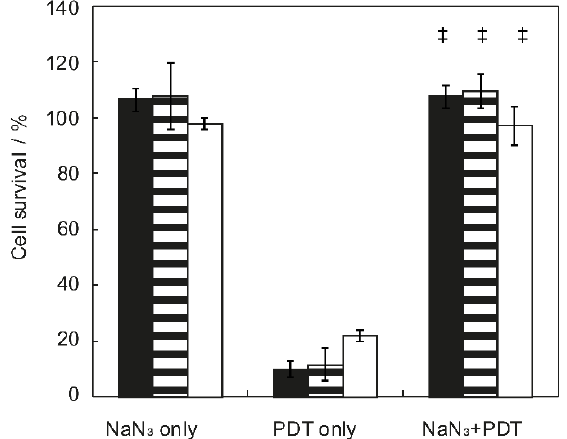
Figure 2. Cell survival of OSC-19-luc2-cGFP (black bar), scc-U2 (dashed bar), and scc-U8 (white bar) cells treated with either NaN 3 only, cetuximab-IRDye700DX mediated photodynamic therapy (PDT) or the combination using a 24 h DLI and illuminated with 20 mW·cm − 2 to a fluence of 15 J·cm − 2 for OSC-19-luc2-cGFP and scc-U2 and 7 J · cm − 2 for scc-U8. ‡ statistically significant from PDT only OSC-19-luc2-cGFP and scc-U2 and 7 J·cm − 2 for scc-U8. ‡ statistically significant from PDT only with p < 0.001.